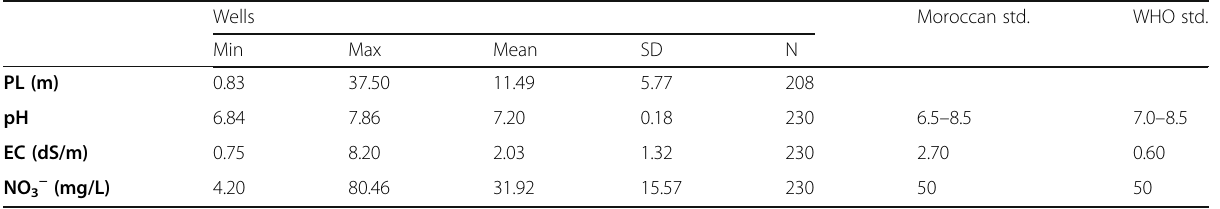
Table 2 Statistics of analyzed parameters of groundwater samples in the study area, and Moroccan-Stds (2002) and WHO (2004) guidelines for drinking